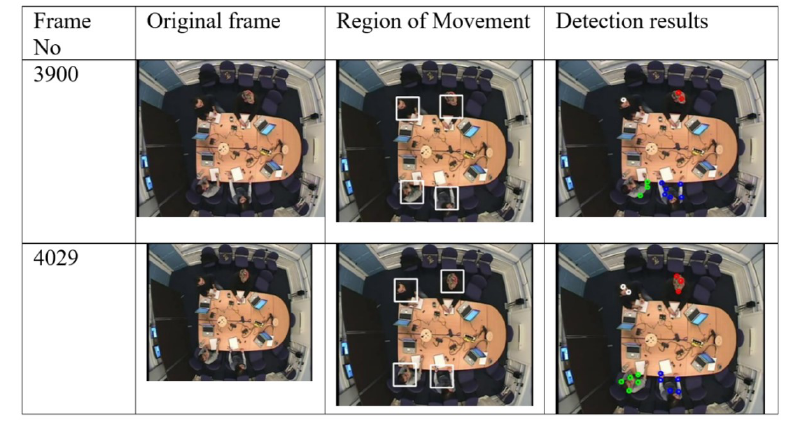
Figure 5. Detection results for slow movement (i.e., people are sitting). Left to right, frame number, original frame, region of movement, detection results.